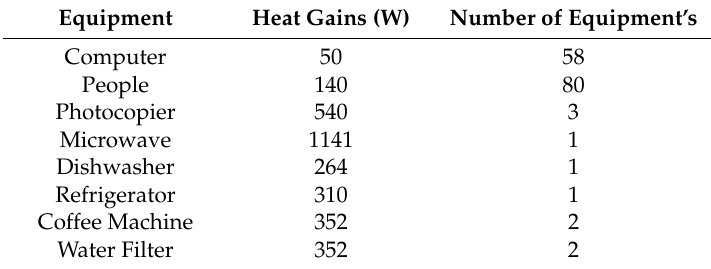
Table 5. Equipment’s internal heat gains (W).